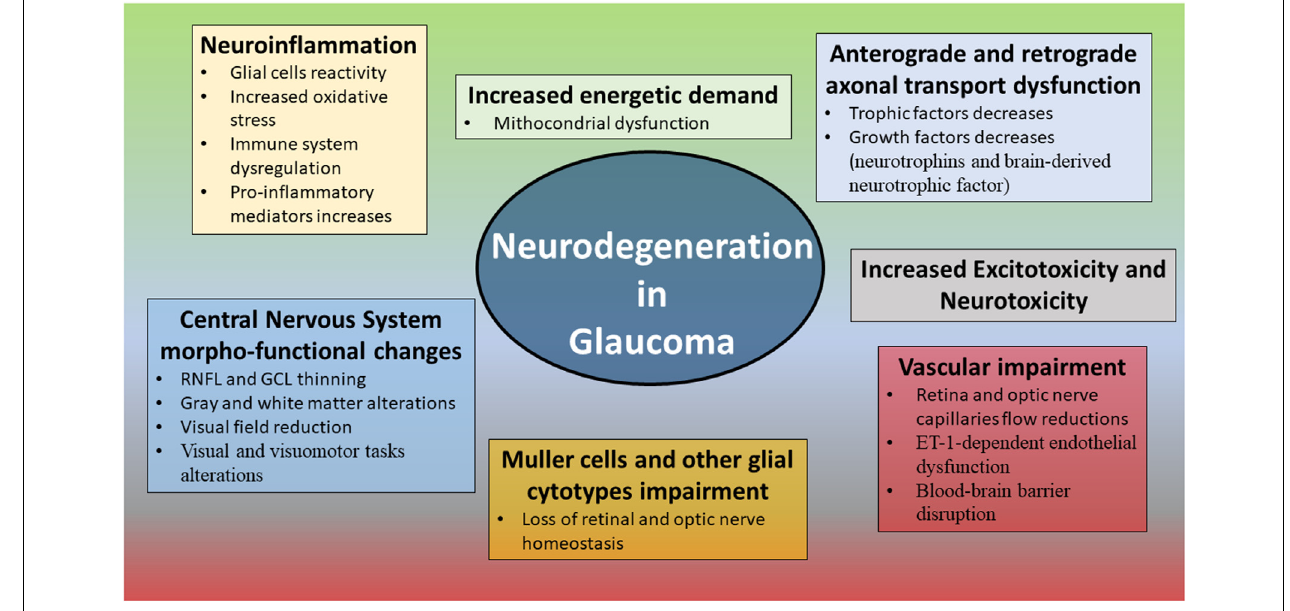
FIGURE 2 | Main alterations associated with neurodegenerative mechanisms in